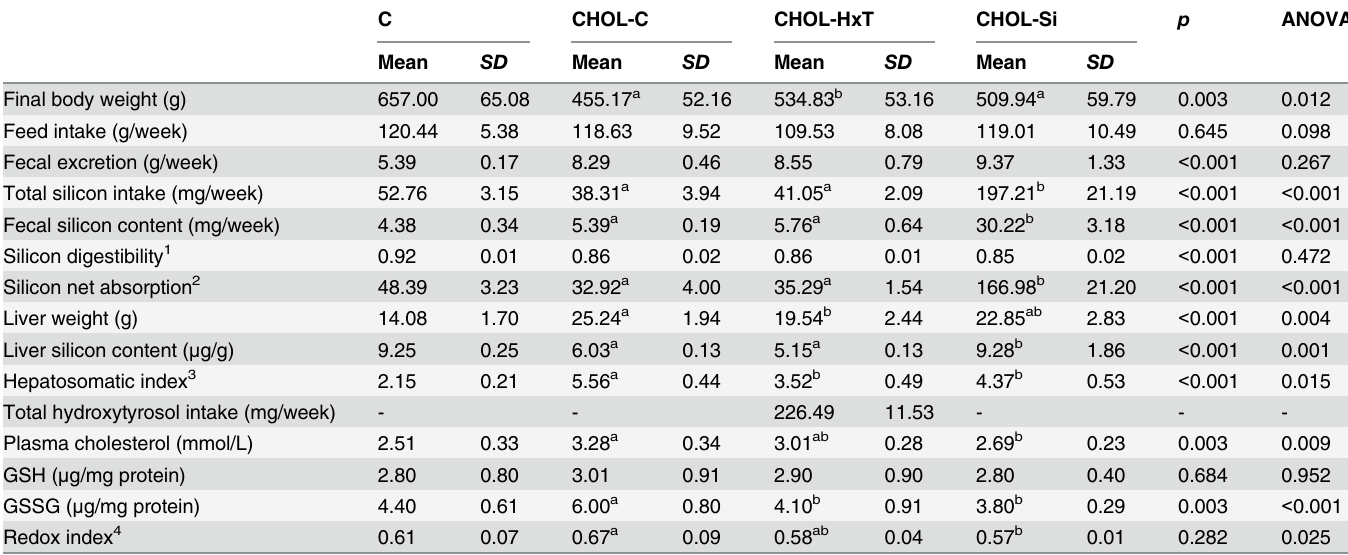
Table 3. Liver weight, hepatosomatic and redox index, plasma cholesterol, glutathione levels and silicon content, net absorption and